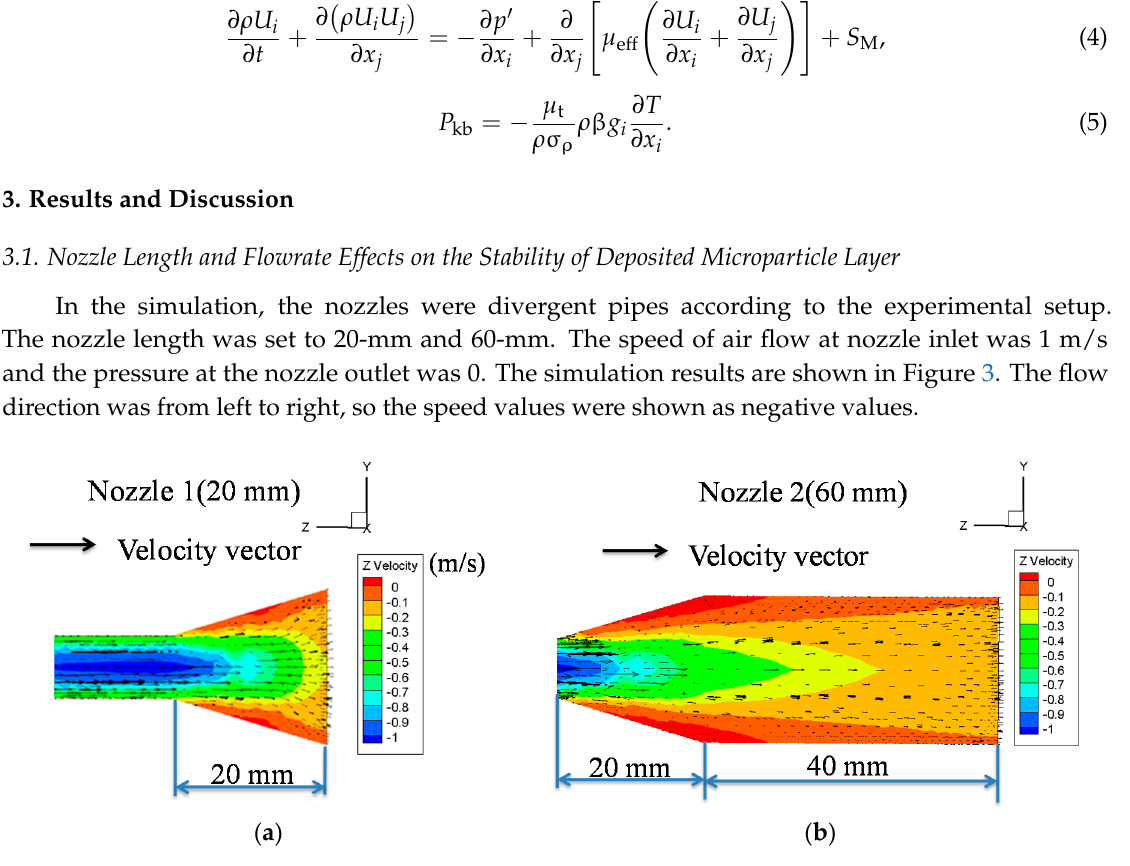
Figure 3. Fluid field simulation of different nozzle length, which was simulated by Fluent using: ( a ) 20 ‐ mm nozzle; and ( b ) 60 ‐ mm nozzle.